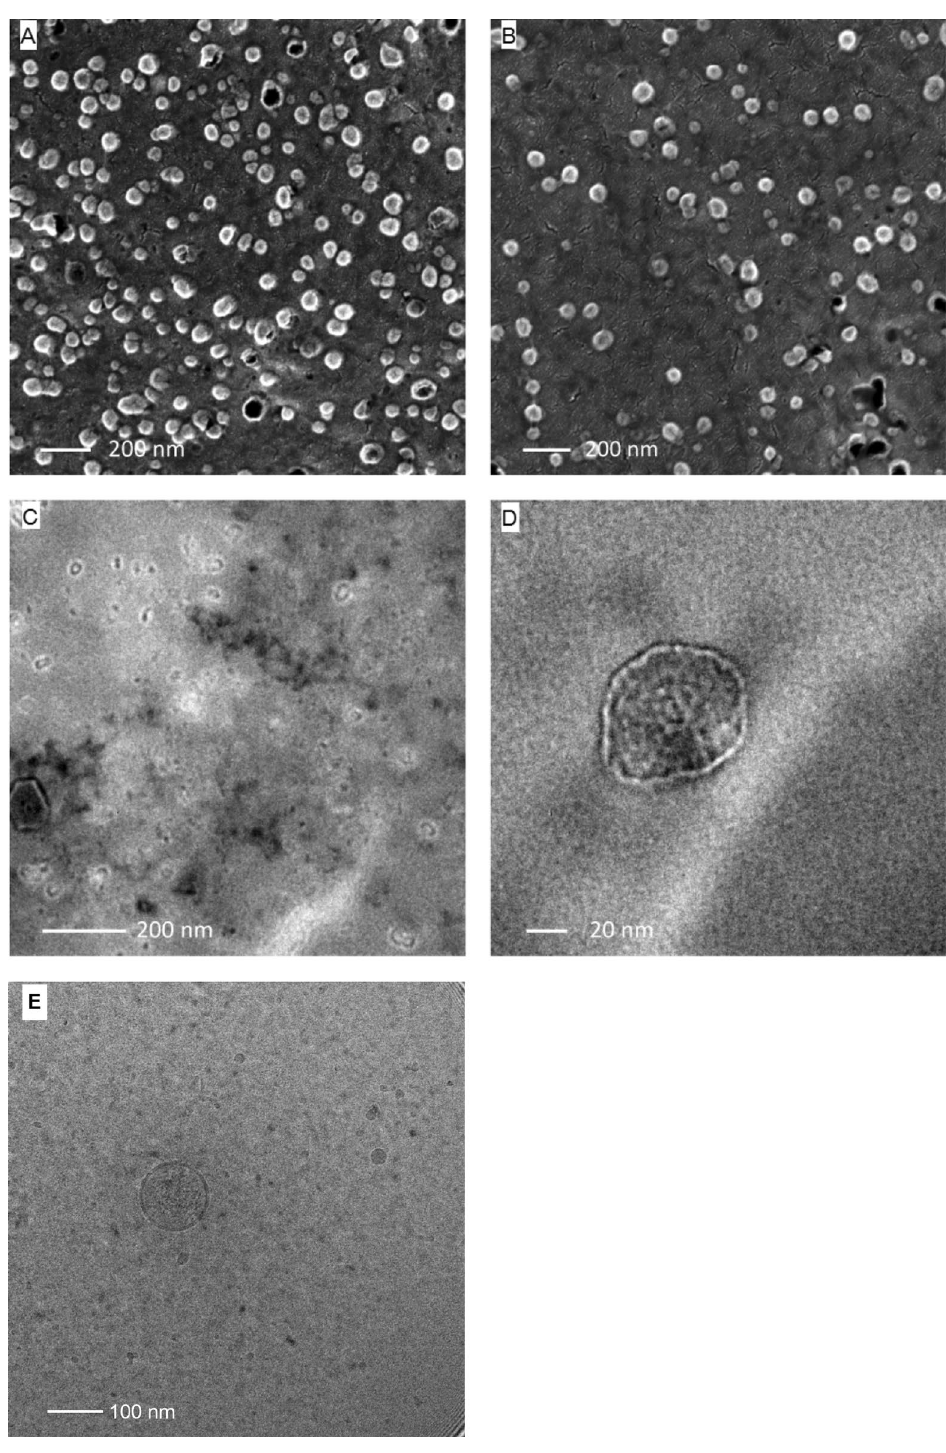
Figure 7. Electron microscopic examination of vesicles purified by SEC and IMAC. Samples were prepared by the two-step FPLC method as described in methods. ( A , B ) FRα-expressing exosomes from HEK293 cells imaged by scanning electron microscopy. The vesicles are of exosome-like size 40–200 nm and cup shaped. ( C ) using transmission electron microscopy it was possible to verify homogenous size distribution of the vesicles as well as ( D ) the presence of a double membrane. ( E ) cryo-TEM imaging of the exosomes confirms the spherical shape and the size of approximately 120 nm as well as the lipid bilayer